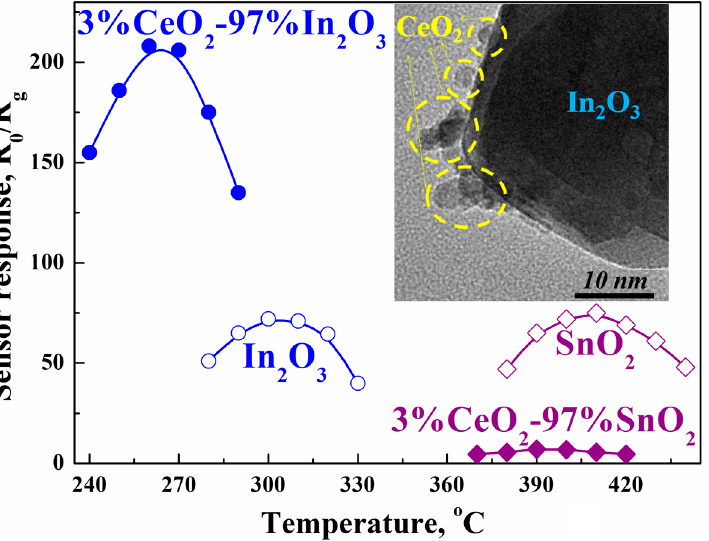
Figure 1. Temperature dependence of the sensor response of composites containing 3% CeO 2 applied for detection of 1100 ppm H 2 . Inset: TEM image of 3%CeO 2 –97%In 2 O 3 composite.